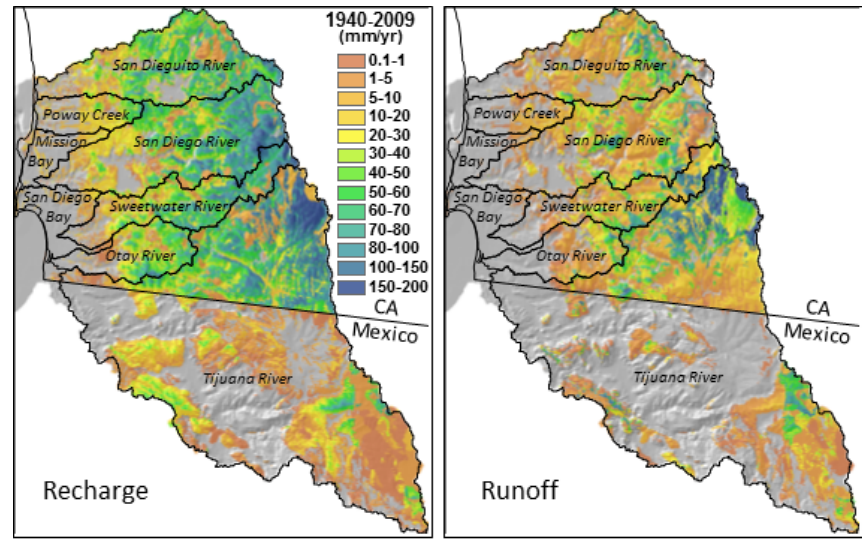
Fig. 9. Maps of average annual recharge and runoff for 1940–2009 calculated using the Basin Characterization Model for the San Diego/Tijuana study area. Gray indicates no recharge or runoff, and the scale applies to both figures.